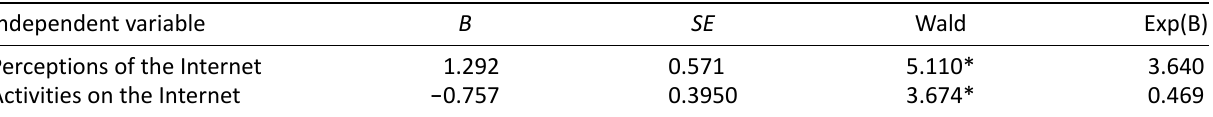
Table 5. Logistic regression results for predicting the motivation to join the course to improve the ability to use the internet. Independent variable